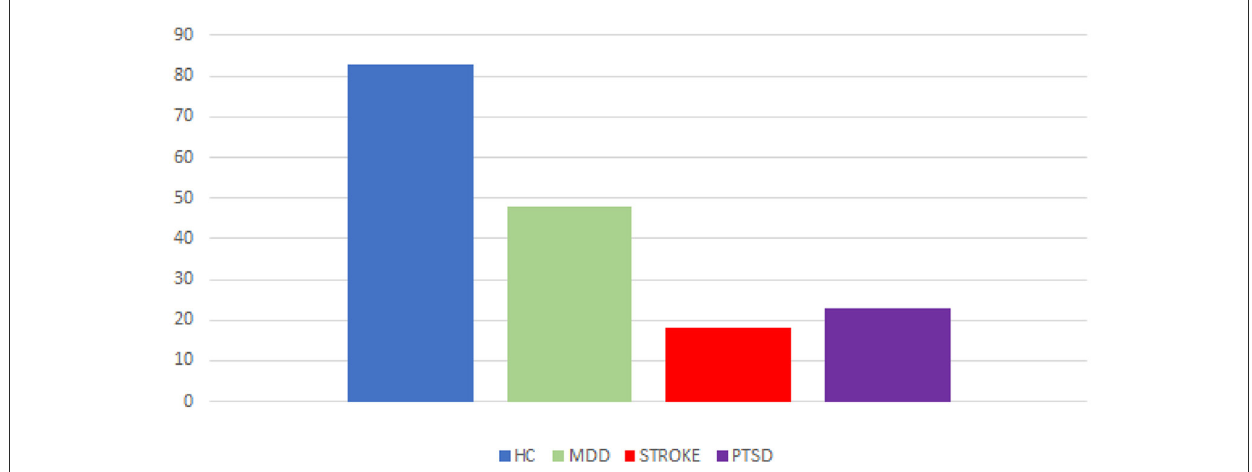
FIGURE2 Proportion of EEG-fMRI-NF studies. Number of studies in relation to neuropsychological diseases (MDD, stroke, PTSD) and healthy control